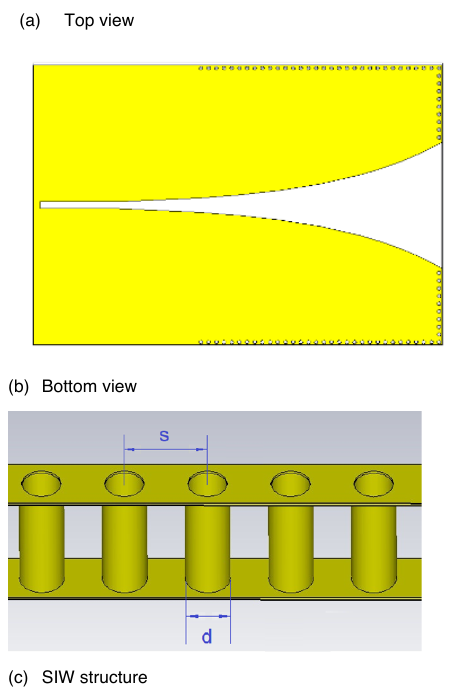
FIGURE 5. Vivaldi antenna using SIW